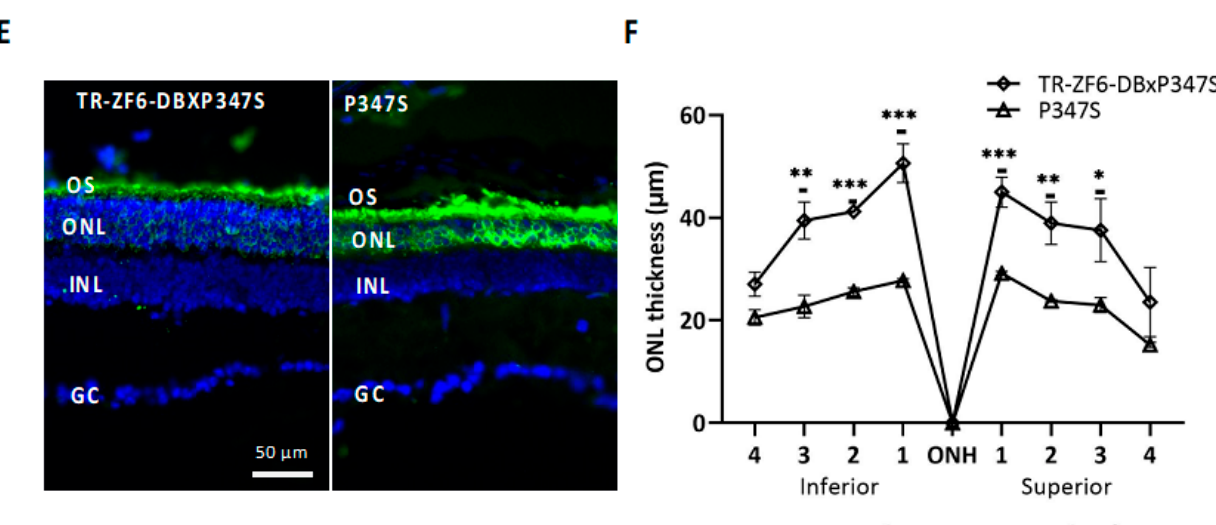
Figure 3. Double transgenic animals TR-ZF6-DBxP347S, derived by the cross of TR-ZF6-DB with P347S RHO-AdRP mice. ( A ) qReal Time PCR of mRNA expression levels (2 − ∆ CT ) of the ZF6-DB in double TR-ZF6-DBxP347S ( n = 4 eyes) compared to P347S RHO-AdRP ( n = 5 eyes) on P30 retina. ( B ) qReal Time PCR of mRNA expression levels (2 − ∆ CT ) of murine endogenous alleles (mRho), human P347S RHODOPSIN mutant allele, and mouse cone Arrestin 1 (mArr1) in P30 TR-ZF6-DB-P347S and P347S RHO-AdRP mice (on the same animals of B). ( C , D ) a- and b-waves amplitudes recorded in scotopic conditions plotted as a function of light intensity (log cd * s/m 2 ) in one-month old TR-ZF6/DB-P347S ( n = 5, white box) and P347S RHO-AdRP mice ( n = 5, grey box). Statistics: t -test corrected with Holm–Sidak method for multiple comparisons. * p ≤ 0.05, ** p ≤ 0.01, *** p ≤ 0.001. ( E ) Rho Immunofluorescence (green) histological analysis of one-month old TR-ZF6/DB-P347S and P347S RHO-AdRP mice. OS, Outer Segment. IS, Inner Segment. ONL, Outer nuclear Layer. INL, Inner Nuclear Layer. GC, ganglion cell layer. ( F ) Retinal “spidergram” showing ONL thickness from the optic nerve head (ONH) to the inferior and superior hemispheres of double TR-ZF6-DBxP347S ( n = 3 eyes) and P347S ( n = 3 eyes). Statistics: t -test corrected with Holm–Sidak method for multiple comparisons. * p ≤ 0.05, ** p ≤ 0.01, *** p ≤ 0.001.